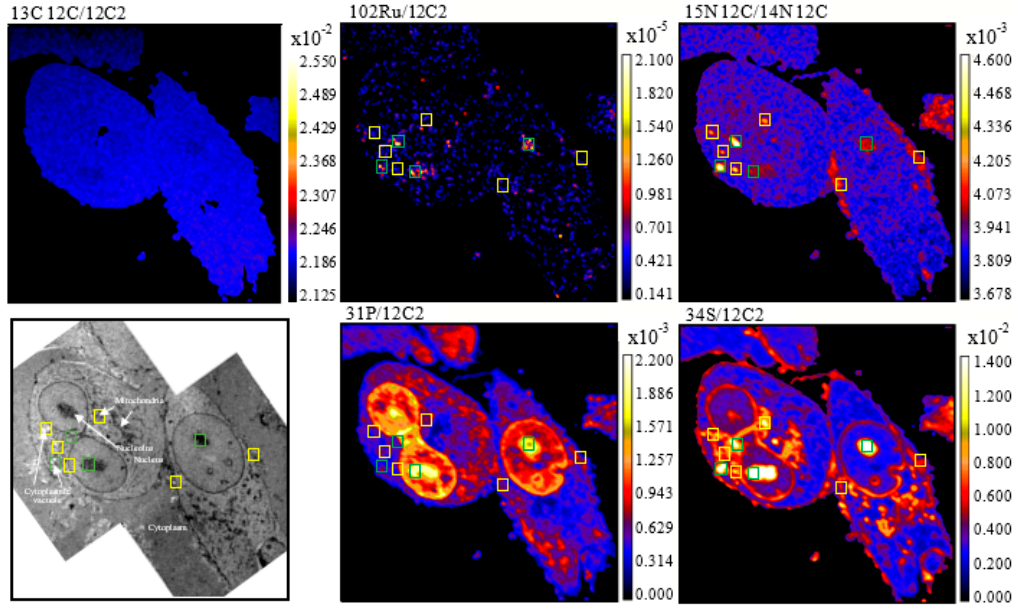
Figure 1. NanoSIMS secondary ion maps of 31 P − / 12 C 2 − , 34 S − / 12 C 2 − , 14 N 12 C − / 12 C 2 − , 15 N 12 C − / 14 N 12 C − , 102 Ru − / 12 C 2 − , and 13 C 12 C − / 12 C 2 − and TEM images of MDA-MB-231 cells treated with 15 N/ 13 C-labelled RAPTA-T (500 µ M, 24 h). Blue boxes indicate Ru-enriched hotspots, yellow boxes indicate 15 N-enriched hotspots, and green boxes indicate hotspots co-enriched with 15 N and Ru. Cellular organelles are labeled in the TEM image.